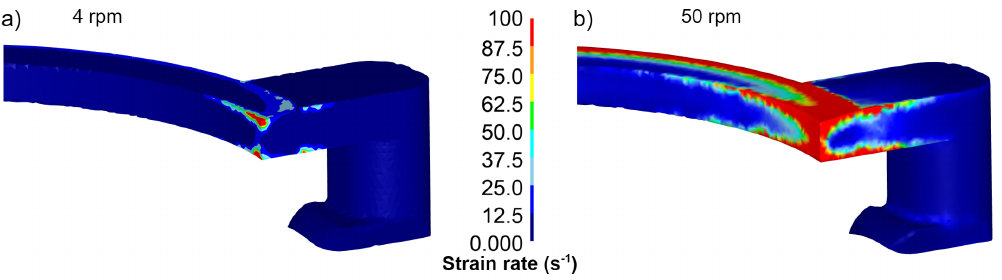
Figure 10. Strain rates in the extrusion grip zone. ( a ) rotational speed 4 RPM; ( b ) rotational speed 50